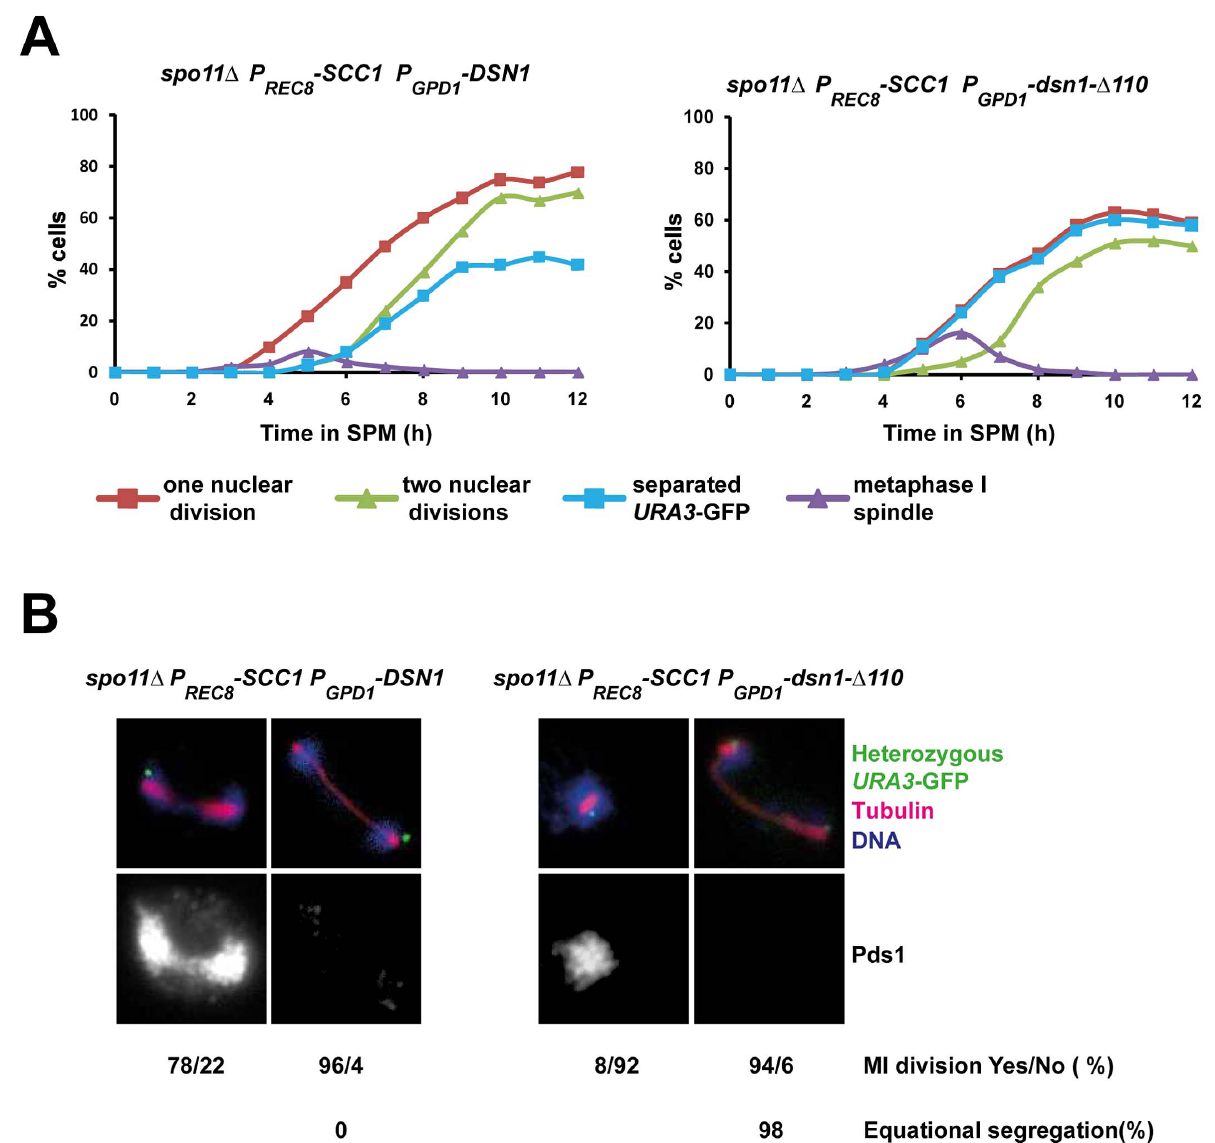
Figure 4. Replacement of cohesin subunit Rec8 by Scc1 rescues the nuclear division defect of P GPD1 -dsn1- D 110 cells. A) Immunofluorescence analysis of meiosis in spo11 D P GPD1 -DSN1 P REC8 -SCC1 and spo11 D P GPD1 -dsn1- D 110 P REC8 - SCC1 cells containing Pds1-myc18, and heterozygous URA3 -GFP. The percentage of cells that have undergone at least one nuclear division (red squares), a second division (green triangles), that contain a short bipolar spindle (purple triangles) and that have separated sister URA3 sequences (blue squares) were scored. B) Nuclear division in Pds1 positive and negative cells containing a single bipolar spindle was quantified and the percentage of cells undergoing equational segregation was determined. Data shown above are of a single representative experiment of at least three independent repeats.